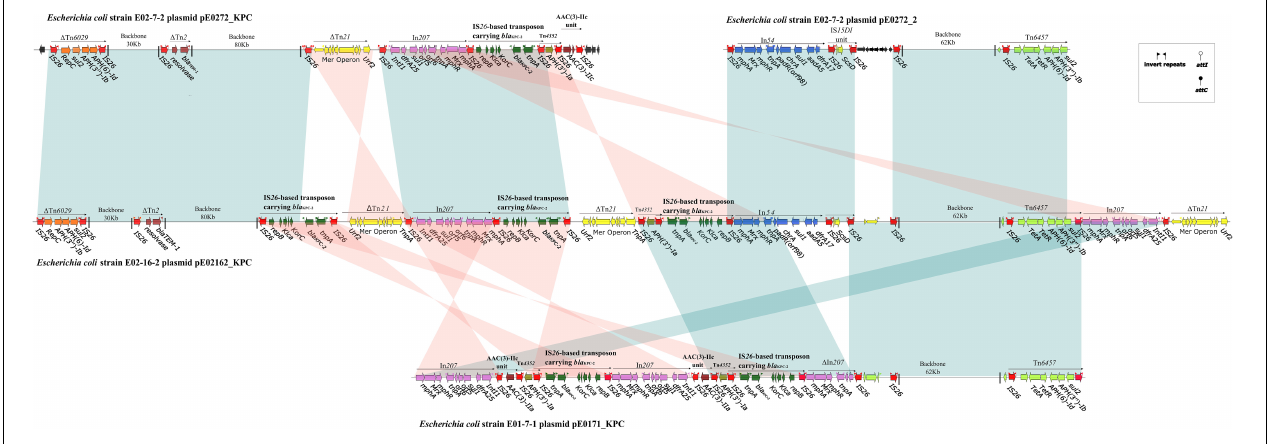
FIGURE 3 | Linear comparison of sequenced plasmids. Genes are denoted by arrows and are colored based on the gene function classification. Shaded regions denote regions of homology ( > 99% nucleotide similarity). The backbone sequence is denoted by a shortened black line, not to